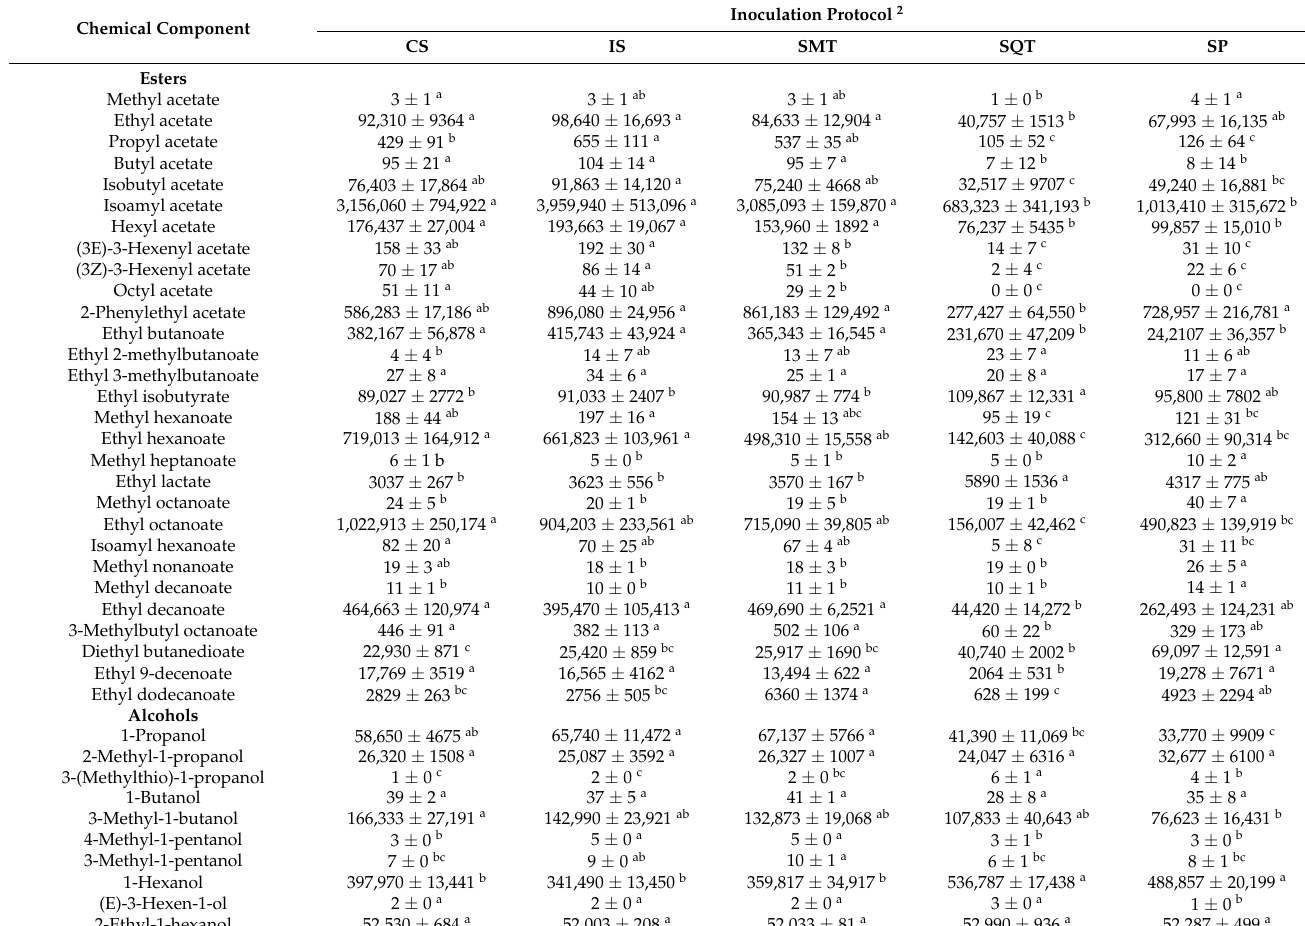
Table 4. Minor volatiles ( µ g/L) 1 of wines produced in microvinifications (mean ± SD, n = 3 or n = 2 in SP). Values not sharing a letter are significantly different ( p <